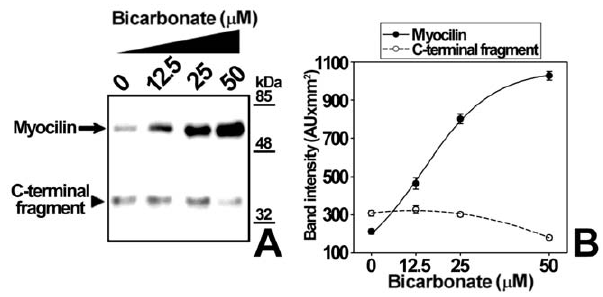
Figure 9. Effect of extracellular sodium bicarbonate on myocilin secretion and proteolytic processing. (A) HEK-293T cells (500000 cells/well) were transfected with a cDNA construct encoding myocilin-myc. After transfection cells were cultured in bicarbonate-free HEPES buffered medium (75 mM, pH 7.1) in the presence of different bicarbonate concentrations. Culture media were collected 3 hours later and extracellular recombinant myocilin was analyzed by 10% poly- acrylamide SDS-PAGE and Western blot using an anti-myc monoclonal antibody. Equal amount of total protein was loaded into each well. (B) Quantitation by densitometry of the C-terminal fragment detected in A. Values represent the proportion of this myocilin fragment, expressed as indicated in Fig. 1B. Error bars correspond to the SD of three independent experiments carried out in triplicate. One-way ANOVA analysis for full-length myocilin and C-terminal fragment, p , 0.001 and p , 0.05, respectively.